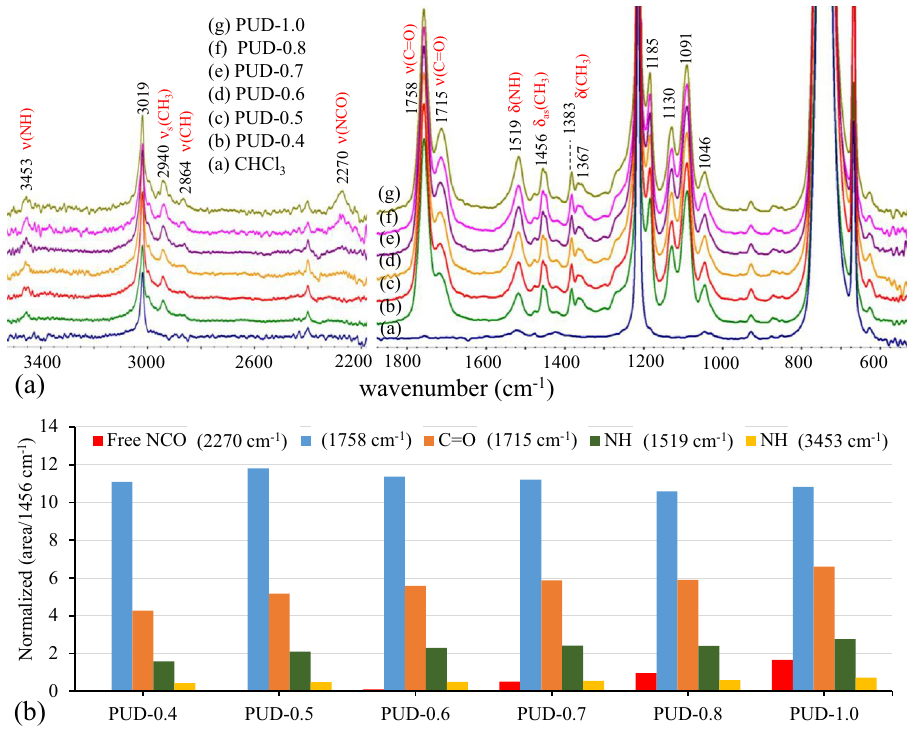
Figure 8. ( a ) ATR-FTIR spectra and ( b ) normalized band areas of PUD/CHCl 3 solutions obtained from different feed ratios of LD12M and HDI.